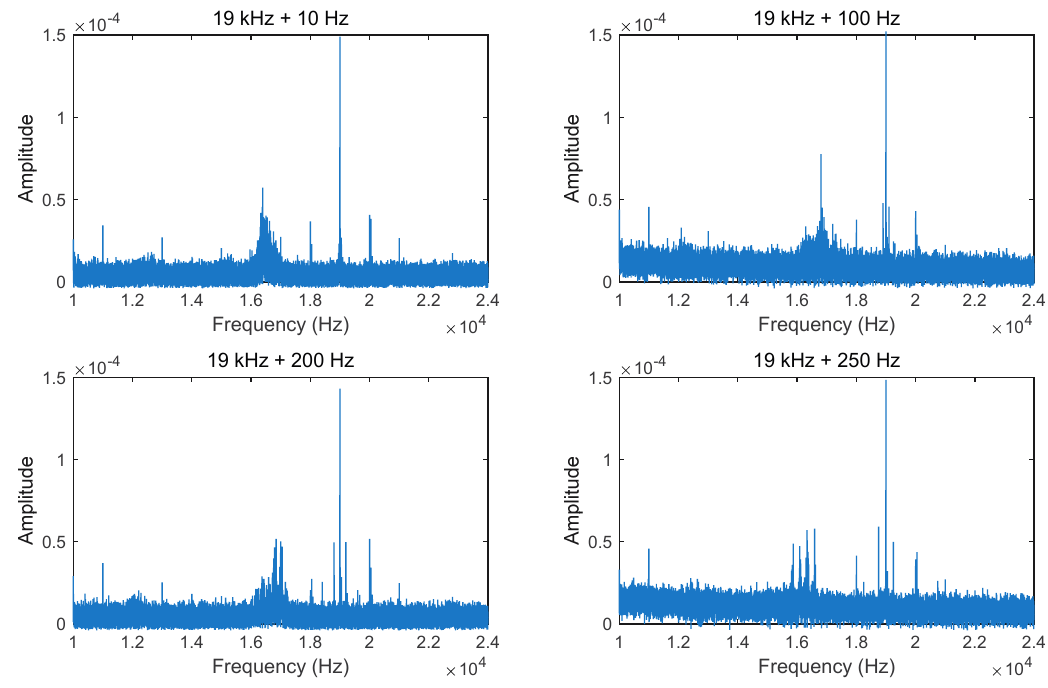
Figure 7. Results with additional low frequency